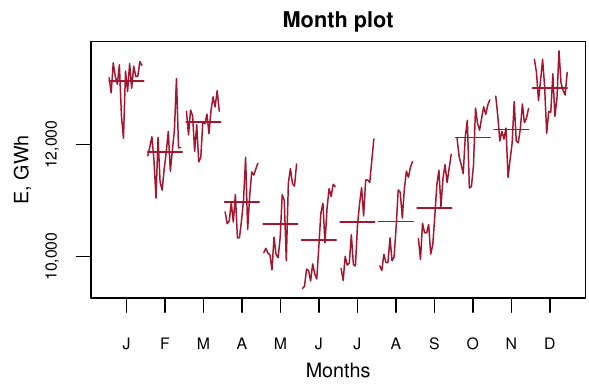
Figure 3. Month plot of energy load for Poland.